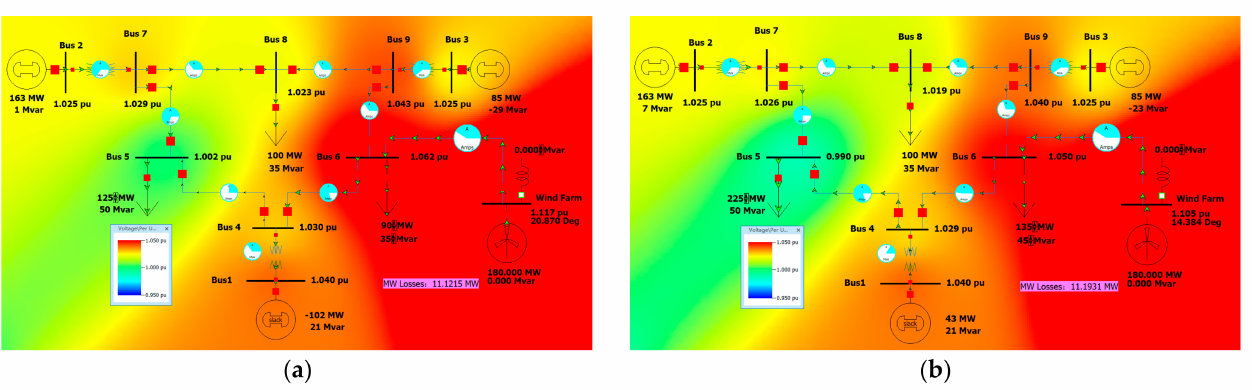
Figure 6. Simulation results with Tower B connected to bus 6 (300 km). ( a ) The results under the minimum load condition and ( b ) the results under the maximum load